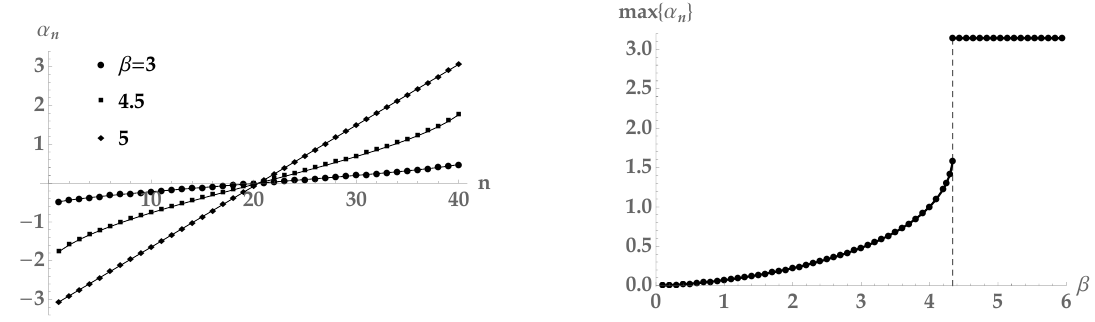
Figure 1 . Exact eigenvalues for N = 40, M = 4 and three values of (cid:12) well below, just below and just above the transition. The right graph represents the plot of the maximal eigenvalue that demonstrates that it jumps at a certain temperature from a value ’ (cid:25)